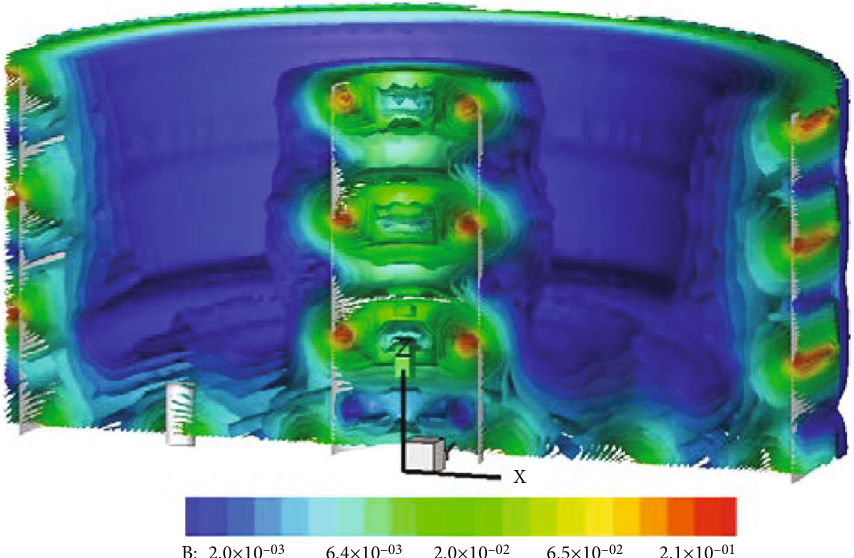
Figure 6: The designed magnetic fi eld for an annular ion thruster